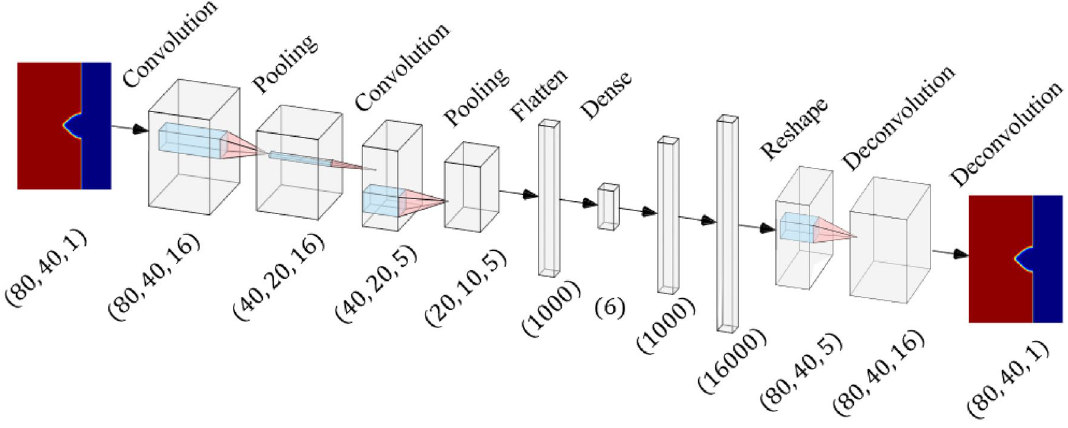
Figure 6. Architecture of